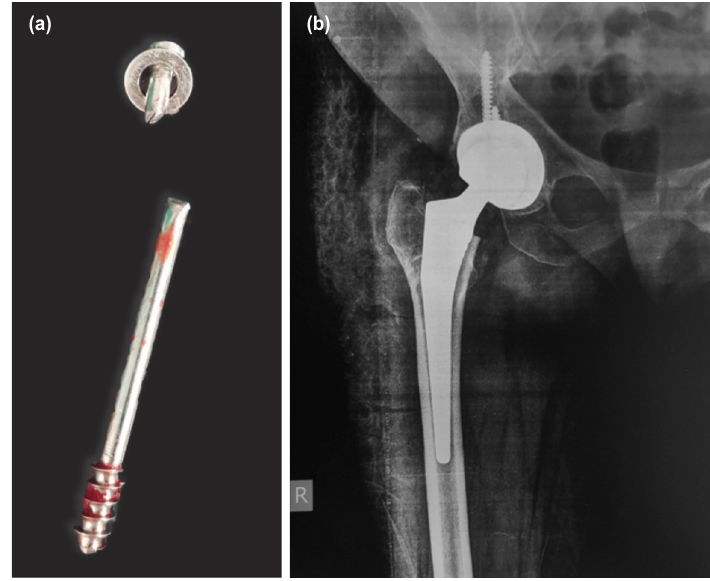
(a) Post-operative clinical photograph of cannulated cancellous stainless-steel screw without metallosis and (b) anteroposterior Fig. 3: radiograph right